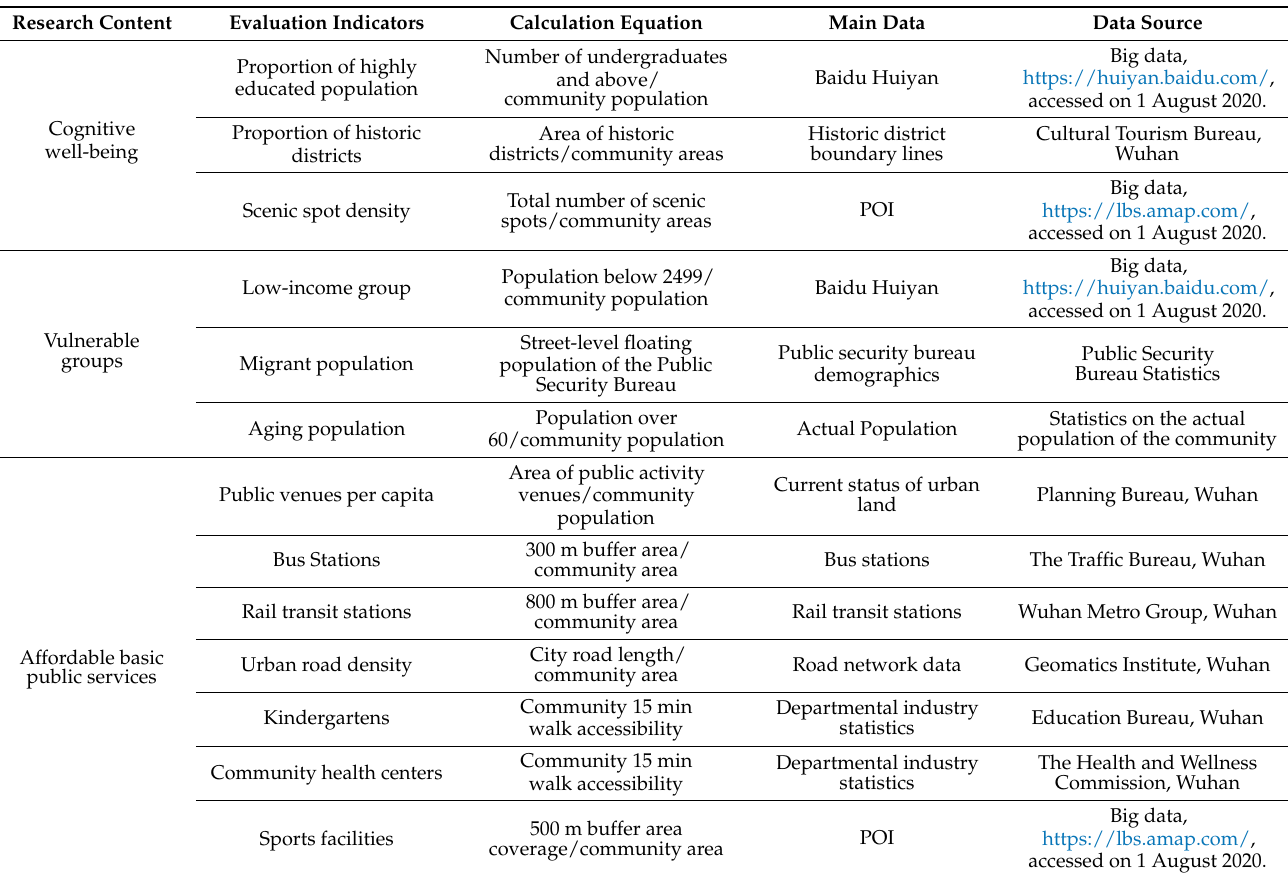
Table 1. Urban renewal evaluation